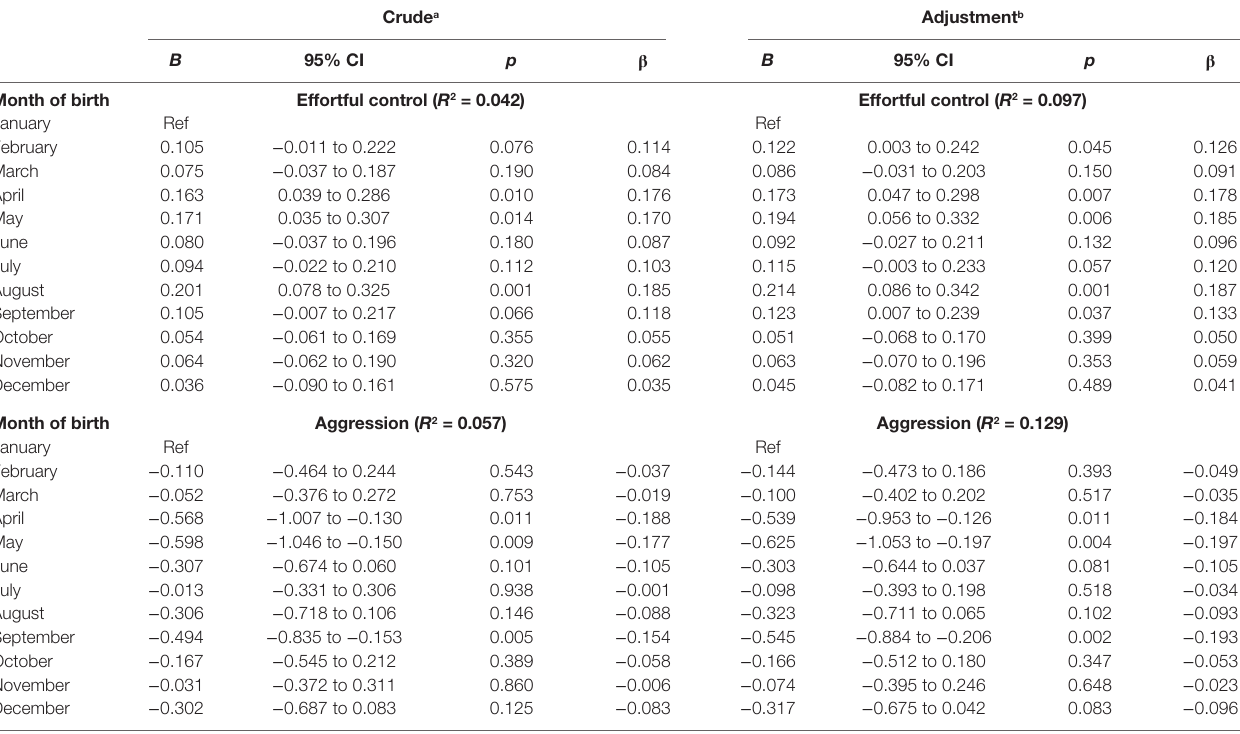
TaBle 4 | Predicting latent factors of effortful control and aggression by month of birth ( N = 885). crude a adjustment